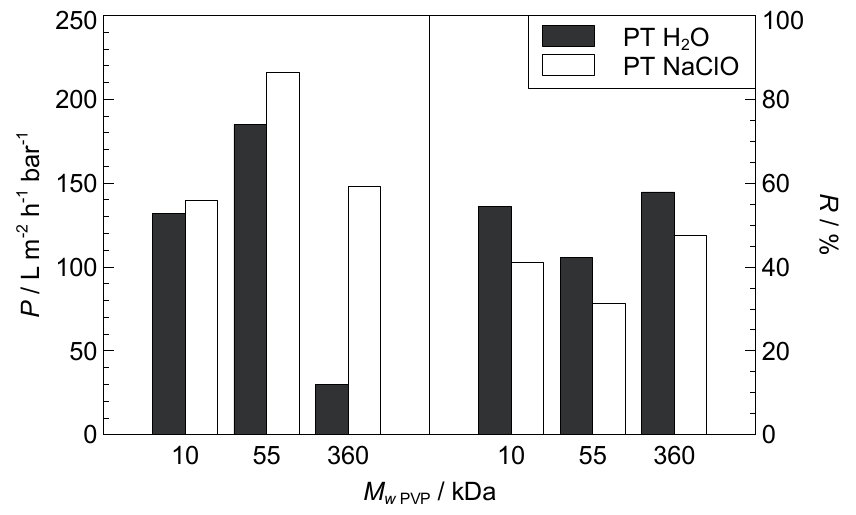
Figure 7. Influence of post-treatment (PT) conditions (1d in H 2 O or 5000ppm NaClO solution, respectively) on permeability ( P ) and retention ( R , dextran 500 kDa) of membranes with varied PVP molecular